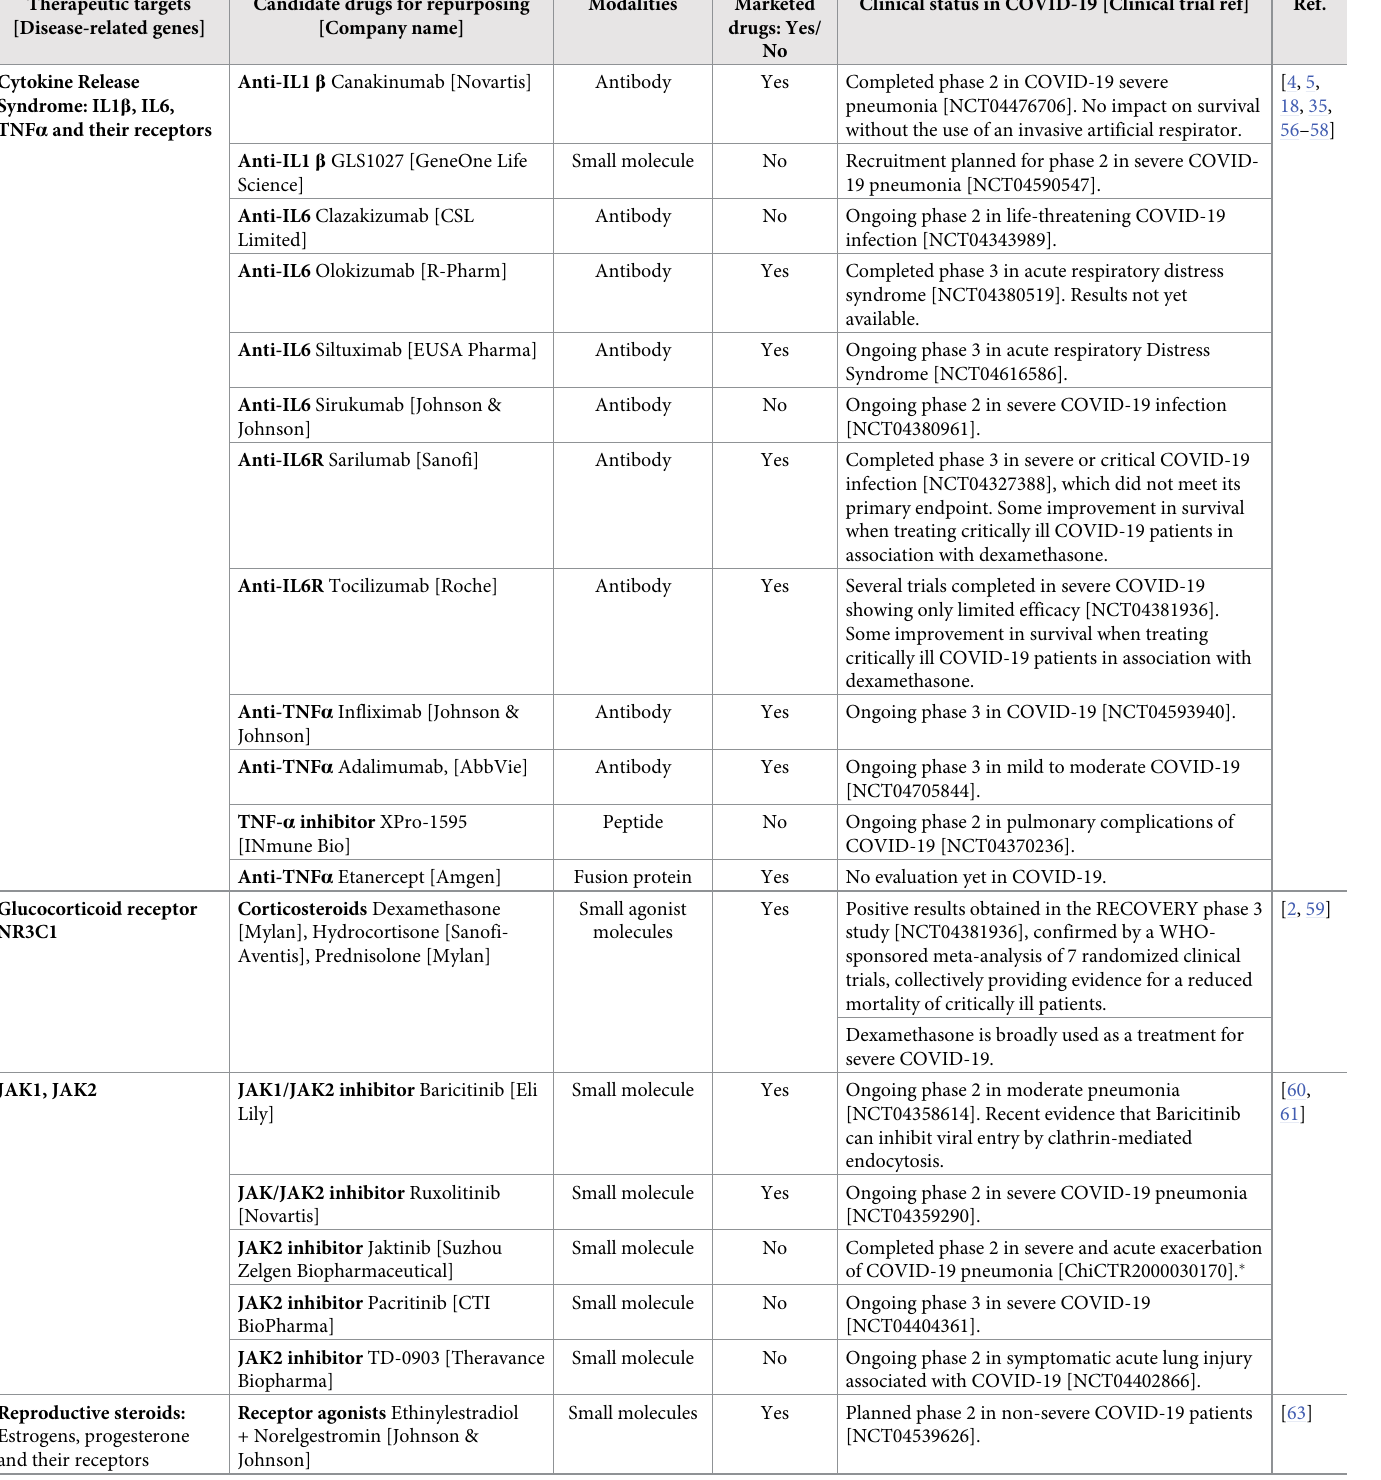
Table 1. Overview of main therapeutic targets and clinical-stage candidate drugs for repurposing in COVID-19- related lung inflammation. Therapeutic targets [Disease-related